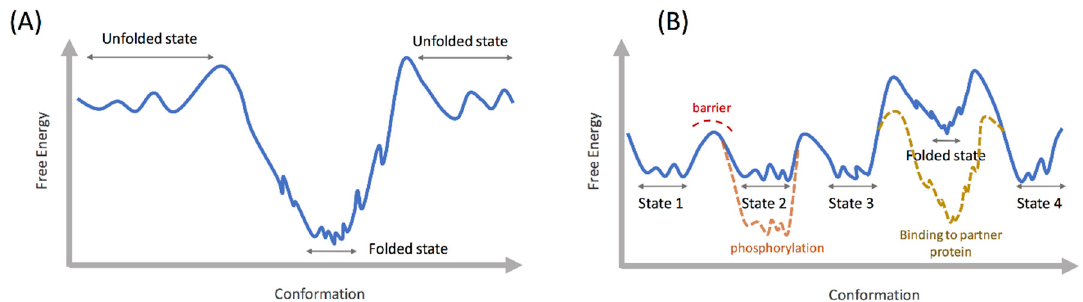
Figure 1. ( A ) Schematic free energy landscape of a folded protein; the folded state is comprised of an ensemble of structurally related states; ( B ) hypothetical intrinsically disordered protein (IDP) landscape showing four disordered (unfolded) states populated in free solution, separated by shallow energy barriers for rapid exchange; the multiple shallow minima in the disordered state free energy landscape indicate high structural flexibility; post translational modifications such as phosphorylation can stabilize one of the states over the others; a folded state is also present in the energy landscape, but only stabilized upon binding to a partner protein.